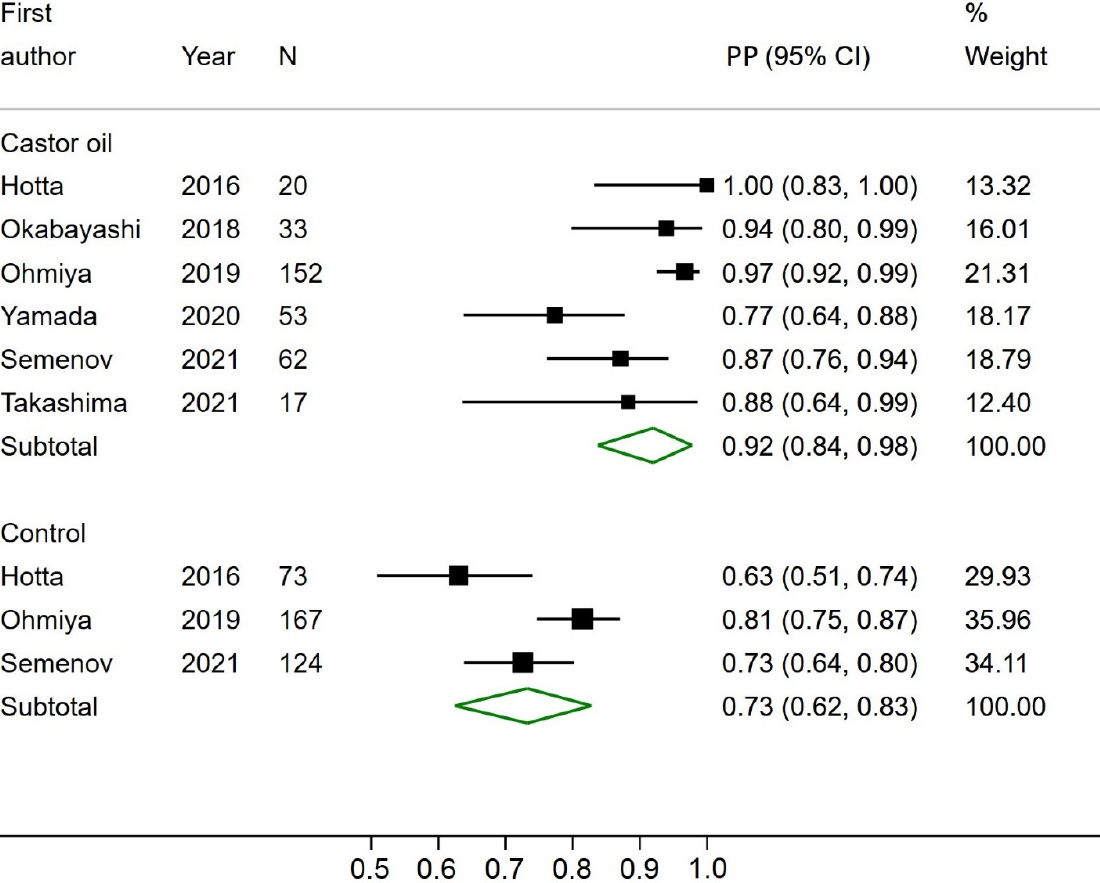
Figure 2. Forest plot of excretion rates of colon capsule endoscopy using castor oil in the bowel preparation regimen and in the control groups. PP—Estimated prevalence proportion.